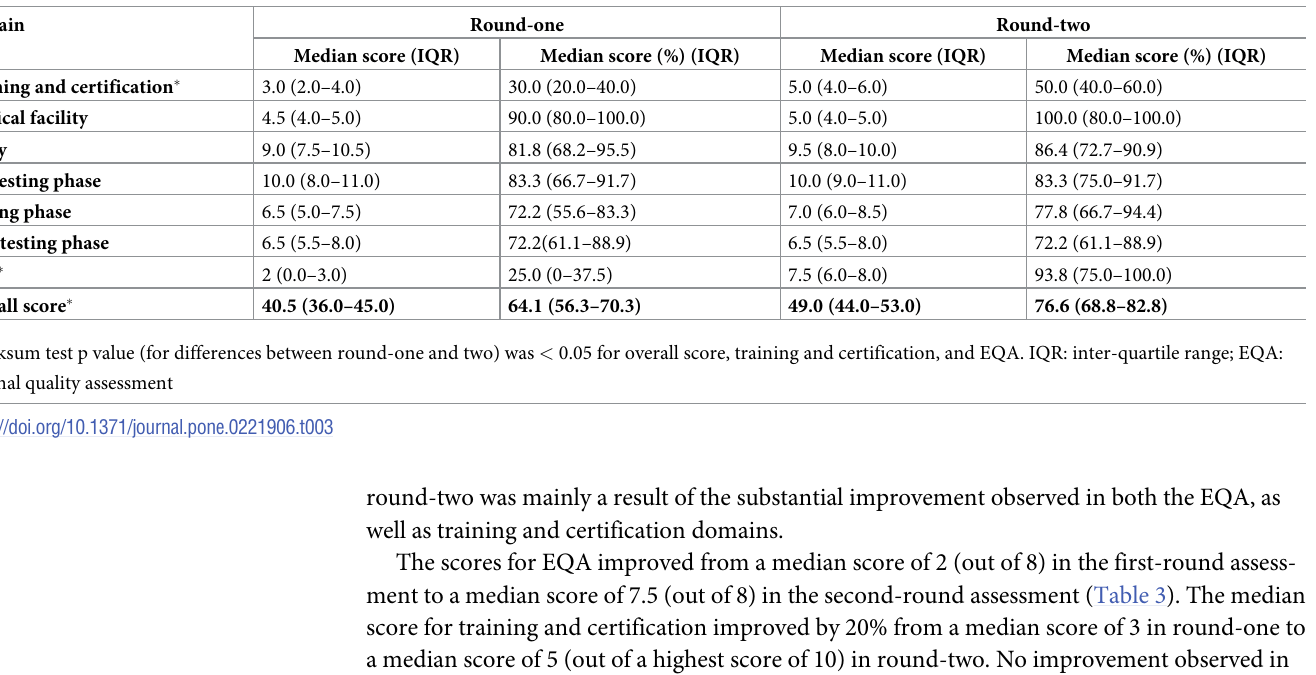
Table 3. Distribution of median scores by assessment round and domains assessed, SPI-RT assessment, 2015–2017, South Africa (N =